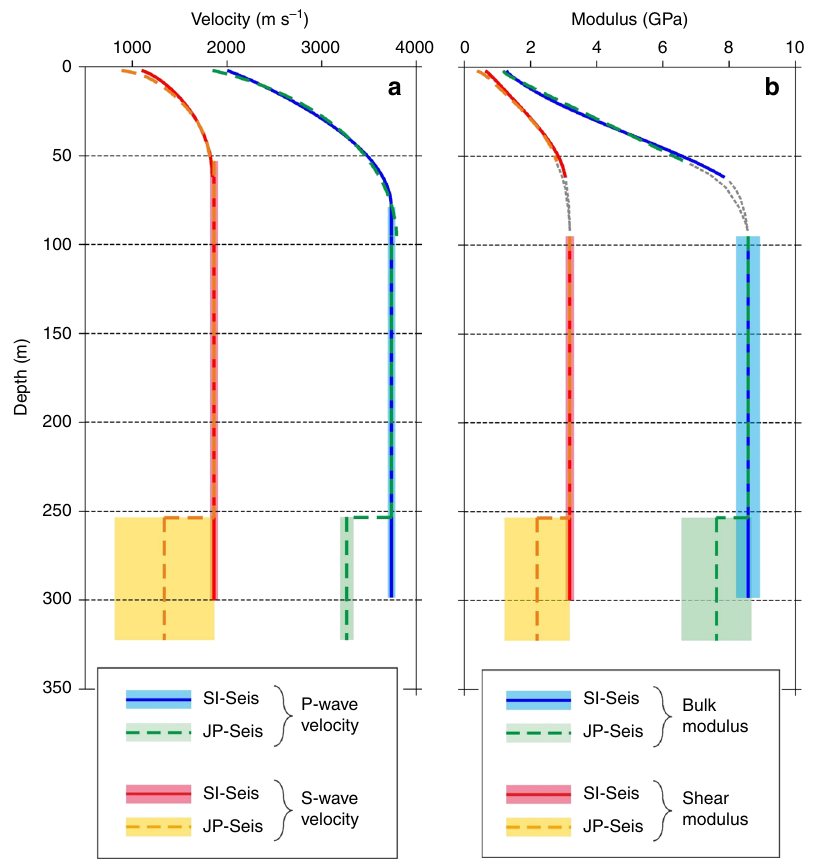
Fig. 7 Depth pro fi les of seismic and elastic attributes at SI-Seis and JP-Seis. a P-wave and S-wave velocities. b Bulk and shear moduli. In both a and b , the shaded bounds represent possible ranges of seismic velocity models derived from Monte Carlo analysis, considering the median plus the interquartile range (see ‘ Methods ’